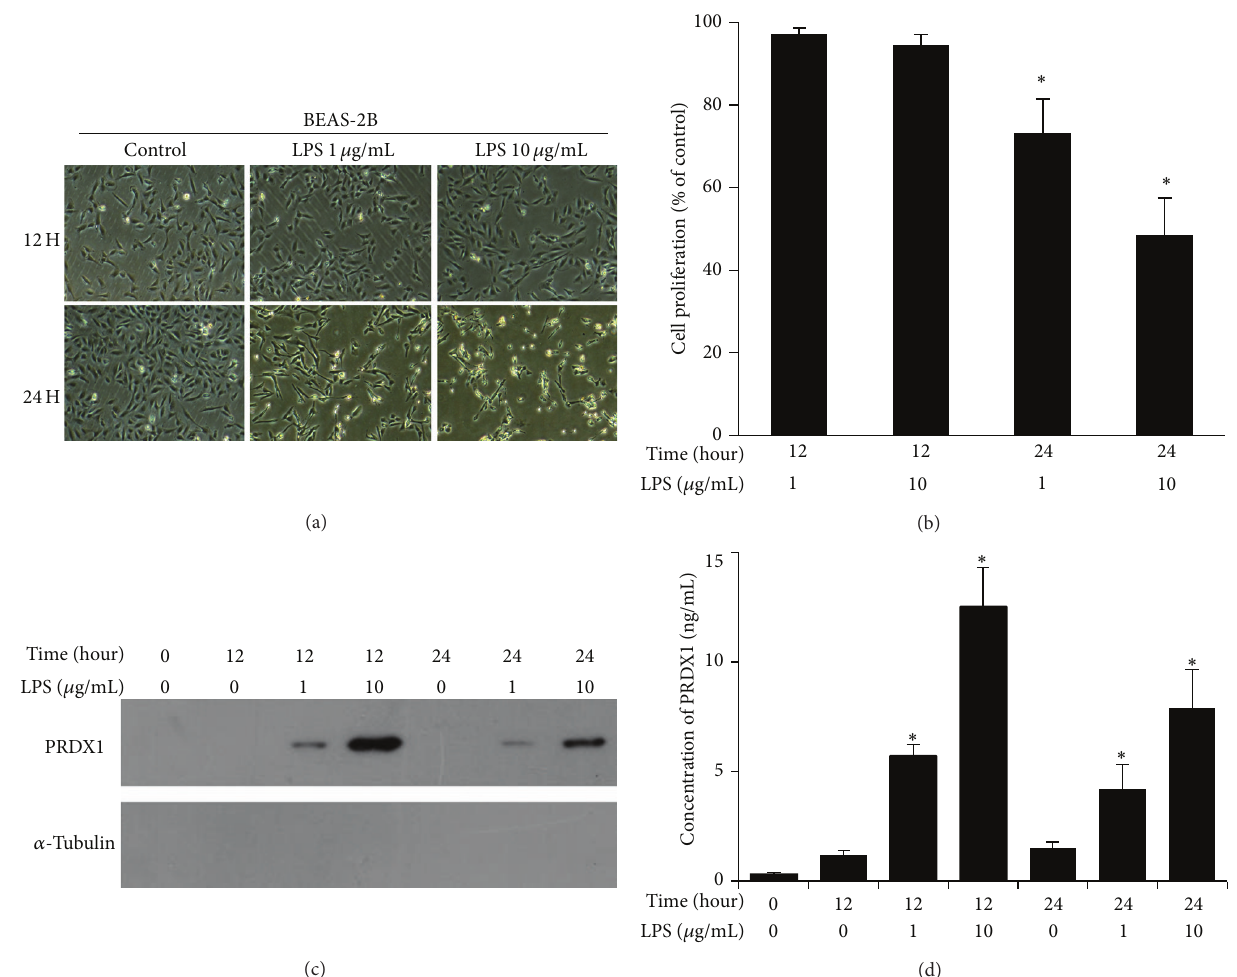
Figure 4: LPS causes upregulation of PRDX1 in vitro. (a) Morphological changes in BEAS-2B cells after treatment with 1 𝜇 g/mL or 10 𝜇 g/mL LPS in 12 hours or 24 hours. BEAS-2B without any treatment was used as a control, original magnification, × 200. (b) Effects of LPS on cell viability. Results are presented as the percentage absorbance of the control group. Data are expressed as the means ± SD. ∗ 𝑃 < 0.05 versus the control group. (c) and (d) the expression of PRDX1 in culture media was evaluated by western blotting (c) and ELISA (d) after challenge with LPS. 𝛼 -Tubulin was not detected in the conditioned media. Experiments in (c) and (d) were repeated at least 3 times, with similar results. Each bar represents the mean ± SD of three independent experiments. ∗ 𝑃 < 0.05